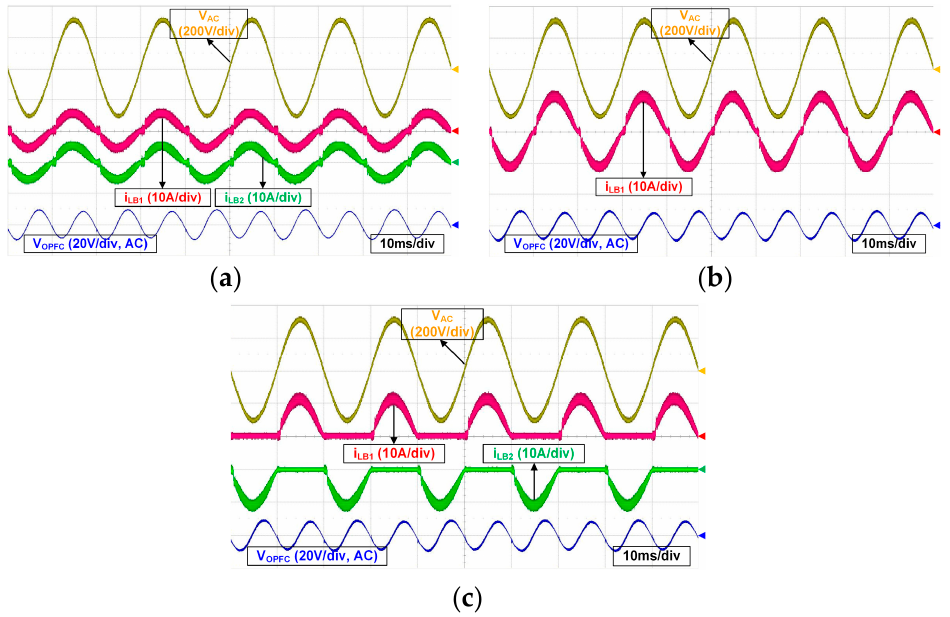
Figure 12. Captured waveforms of the PFC stage at 50% load condition. ( a ) Conventional interleaving